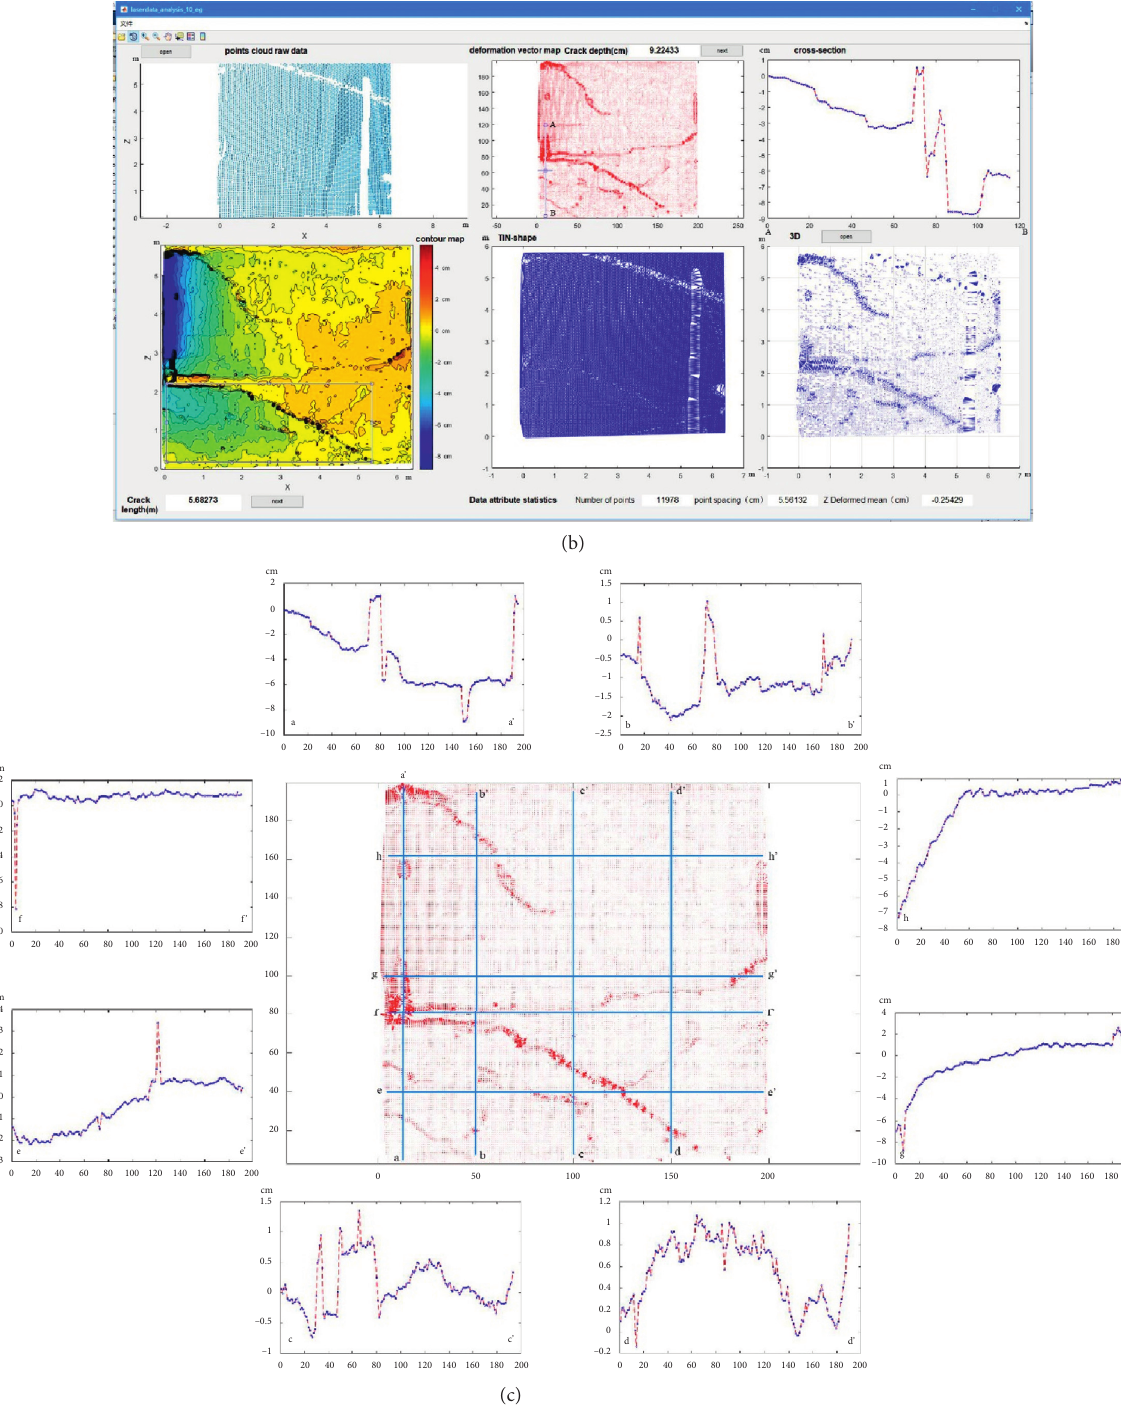
Figure 8: (a) Brick buildings. (b) Brick building information extraction. (c) Wall section of brick (Figure 8(b)). Since the TLS collects point cloud data of the building surface, the actual displacement mis- movement of the walls on either side of the crack is calculated when the model extracts the crack depth of the building. The a-a’ profile shows that the maximum crack depth of about 5.1 cm is located on the left side of